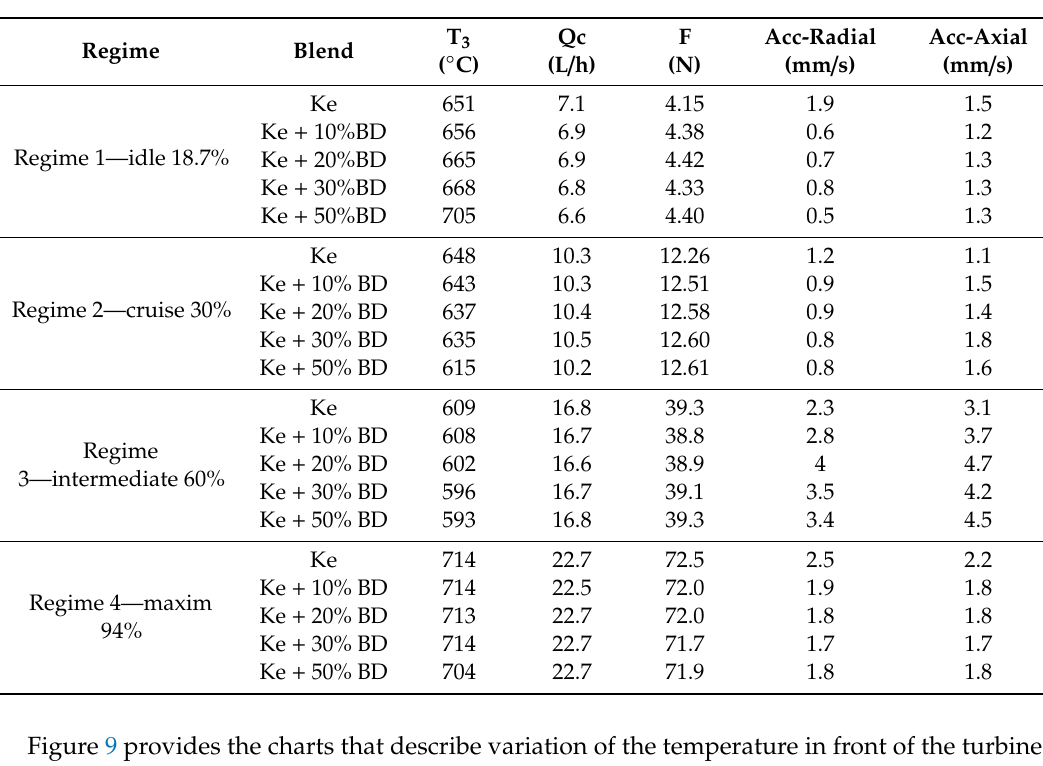
Table 2. Main turbojet engine measured parameters.